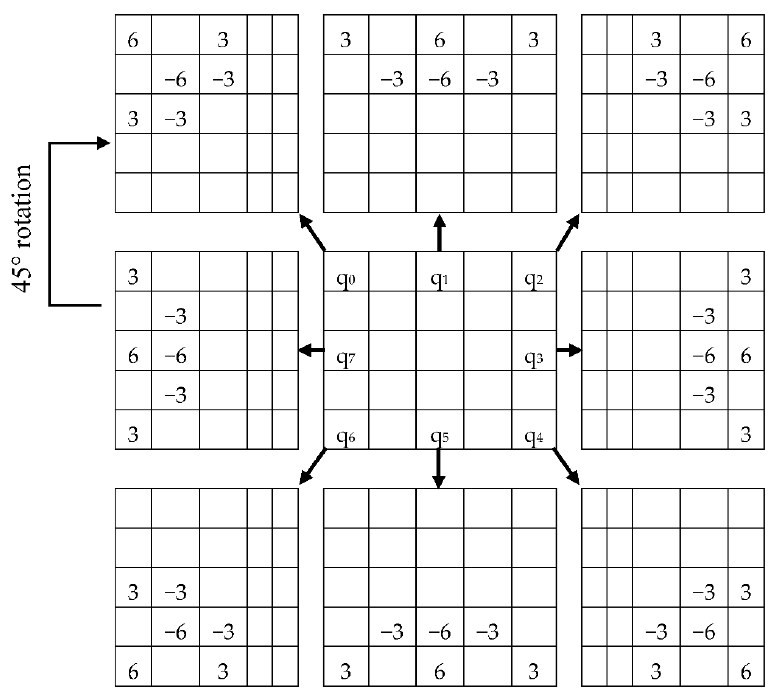
Figure 8. Description of LBP (8, 2) : kernel value.